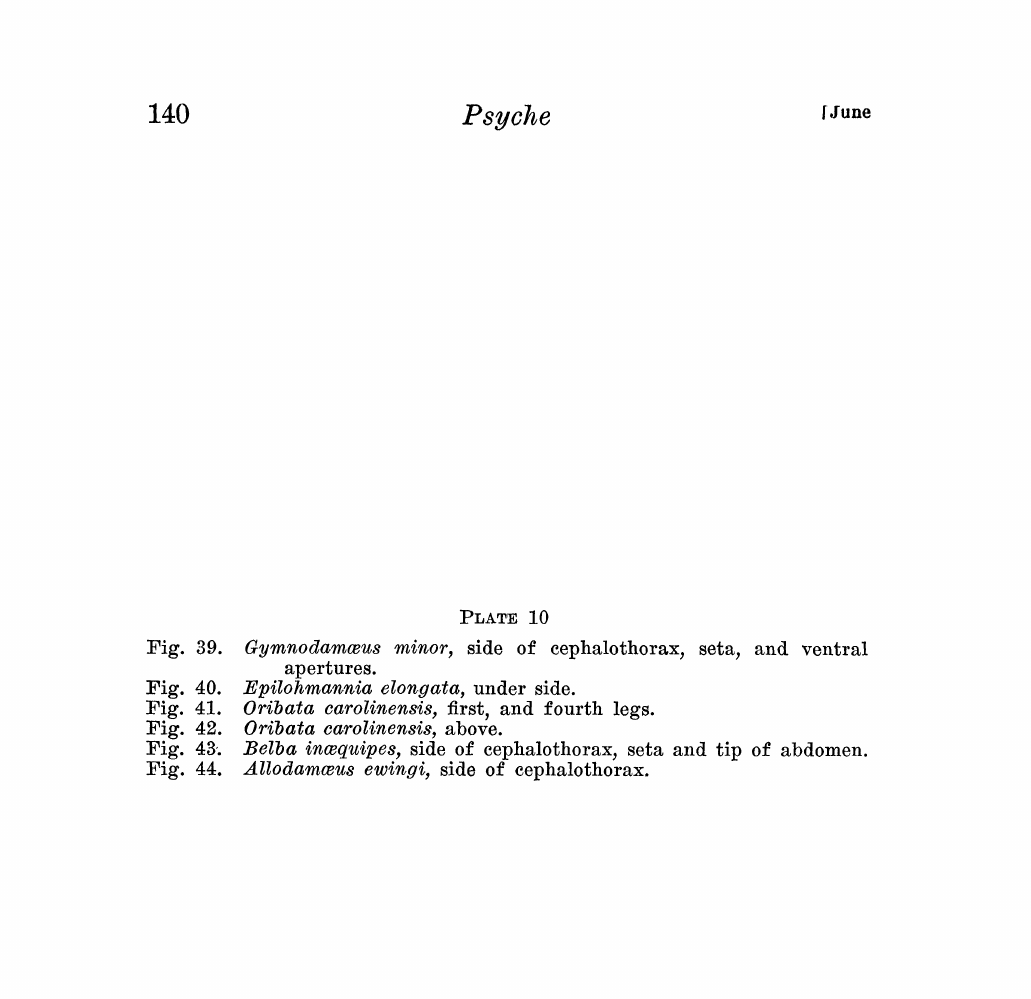
PLAT 10 Gymnodamus minor, side of cephalothorax, seta, and ventral Fig. 39. apertures. Fig. 40. Epilohmannia elongata, under side. Fig. 41. Oribata carolinensis, first, and fourth legs. Fig. 42. Oribata carolinensis, above. Belba incequipes, side of cephalothorax, seta and tip of abdomen. Fig. 43: Allodamceus ewingi, side of Fig. 44.